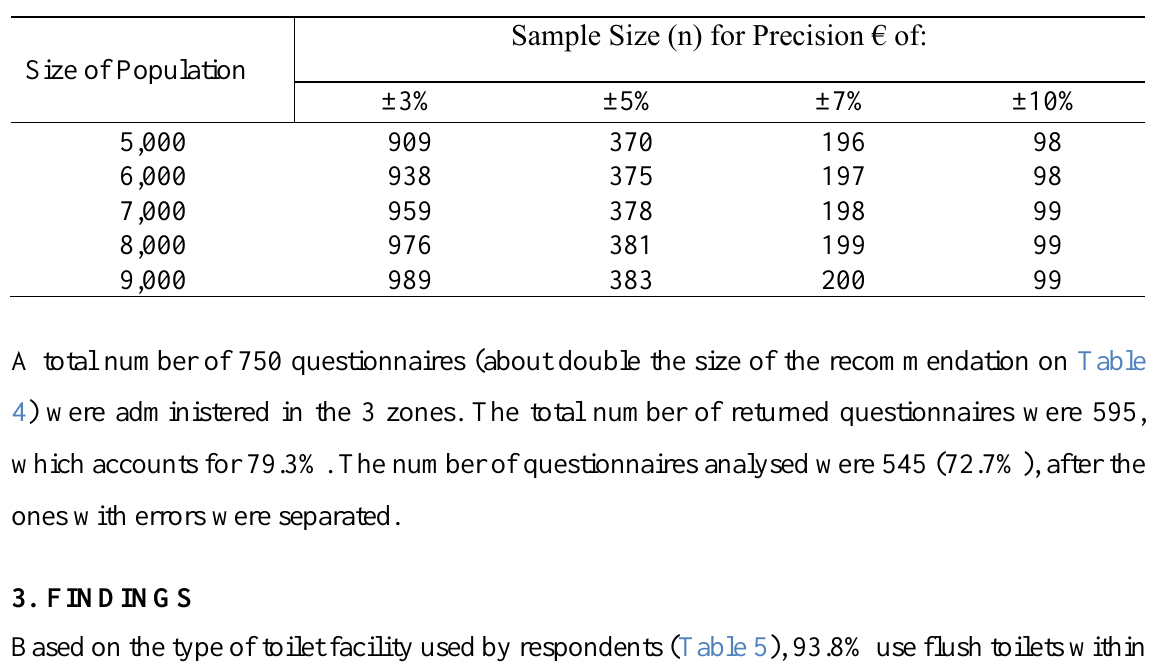
Table 3. Sample size requirements (Glenn D. Israel